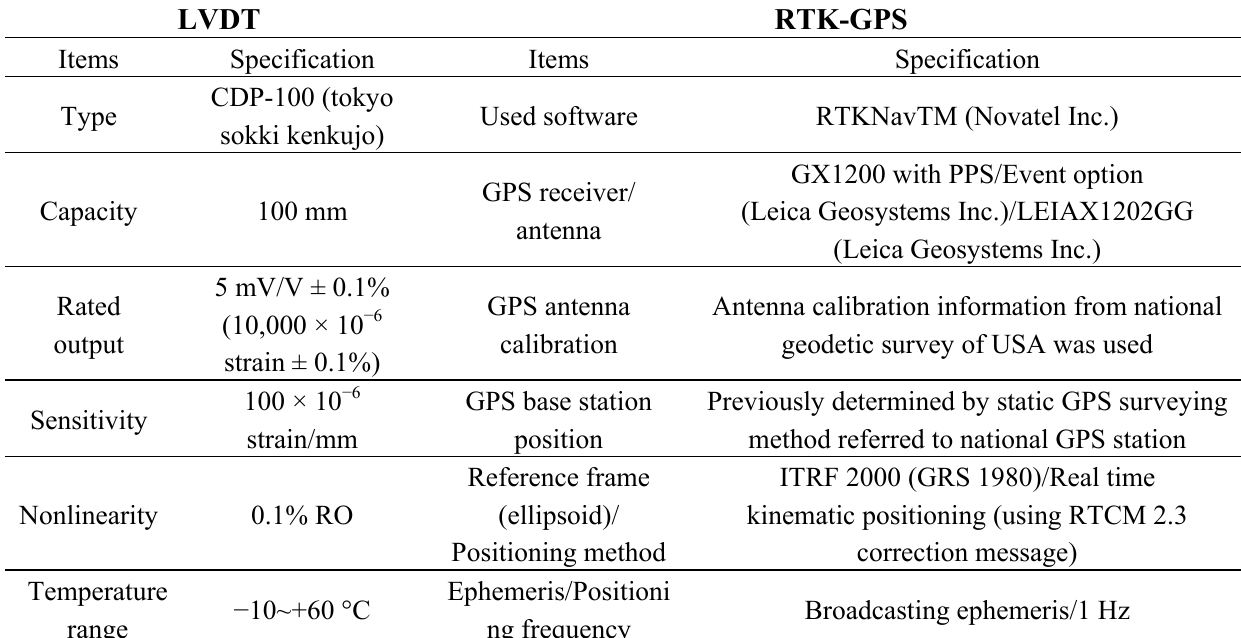
Table 1. Key informations of LVDT transducer and RTK-GPS